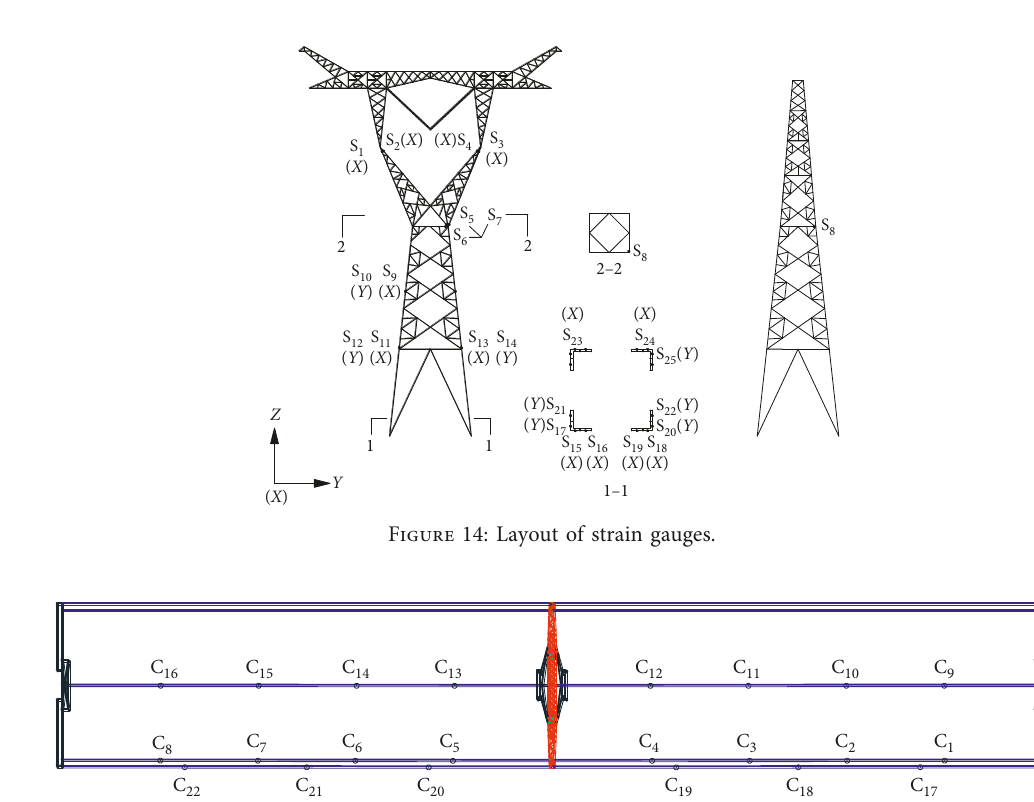
Figure 15: Schematic diagram of the layout of the acceleration sensors on the conductor and ground